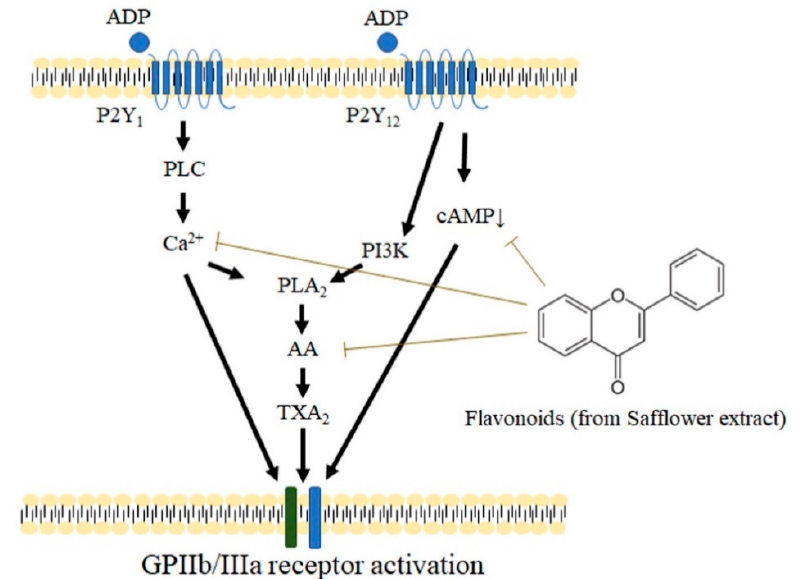
Figure 7. Schematic diagram of the mechanism of safflower extract inhibiting platelet aggregation. The compounds found in safflower extract inhibit the activation of calcium ions in platelets and the transduction of cAMP pathways caused by ADP, thereby inhibiting the expression of TXA 2 in platelets, the activation of membrane protein GPIIb/IIIa, and the aggregation of platelets.